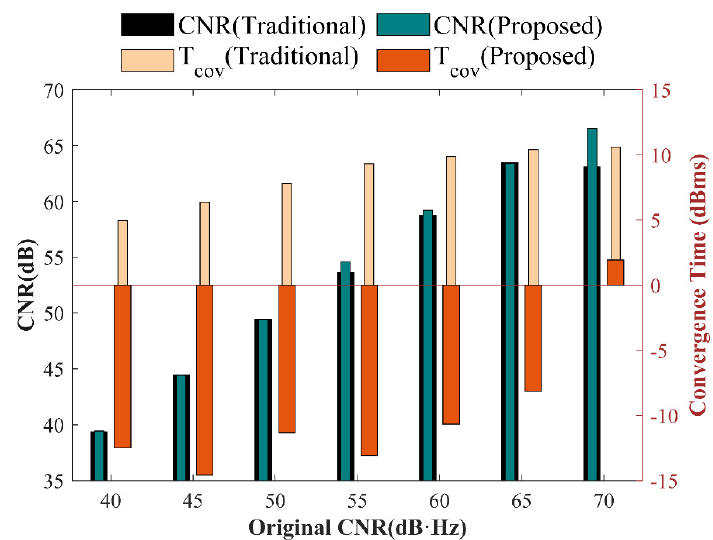
Figure 13. Performance comparison under scenarios with different original CNR.